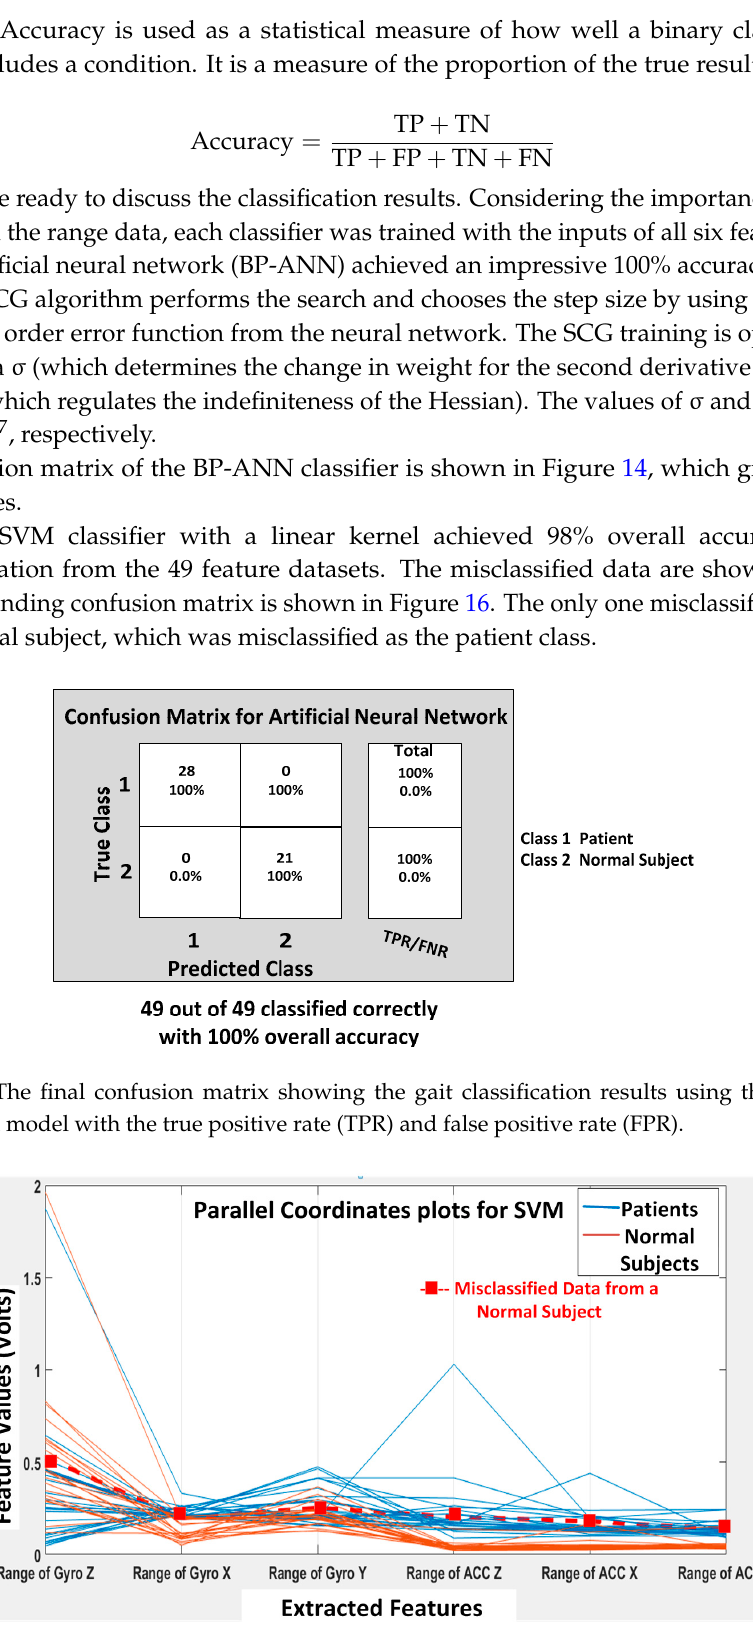
Figure 16. The final confusion matrix showing the gait classification results using the SVM classification model with the true positive rate (TPR) and false positive rate (FPR). The KNN and BDT algorithms were also trained on the data collected and achieved 96% and 94% in accuracy, respectively. The parallel coordinates plots and the confusion matrices are shown in Figures 17–20, respectively. For the KNN classifier, there are two misclassifications: Case 7 of the first normal subject and Case 1 of the second patient were misclassified. Somewhat similarly, for the BDT algorithm, there are three misclassifications: Case 7 of the first normal subject, Case 4 of the fourth patient and Case 6 of the first patient.